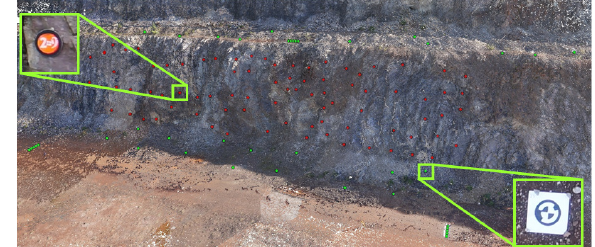
Figure 4: The reference point network allows an extensive ac- curacy evaluation. Markers (right) indicating GCP positions are shown in green, circular targets (left) for quantitative evaluation are in red.